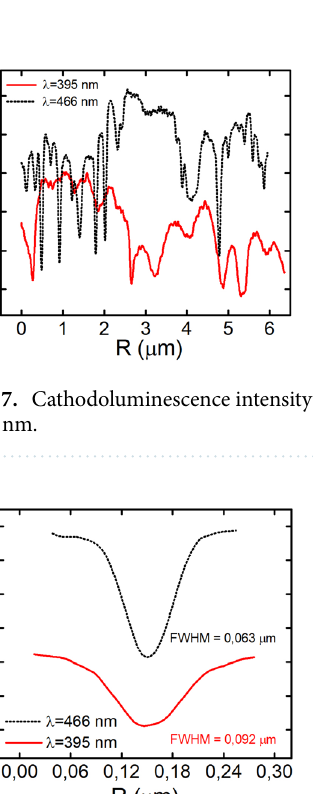
Figure 6. Cathodoluminescence map of sample emitting at λ = 466 nm.